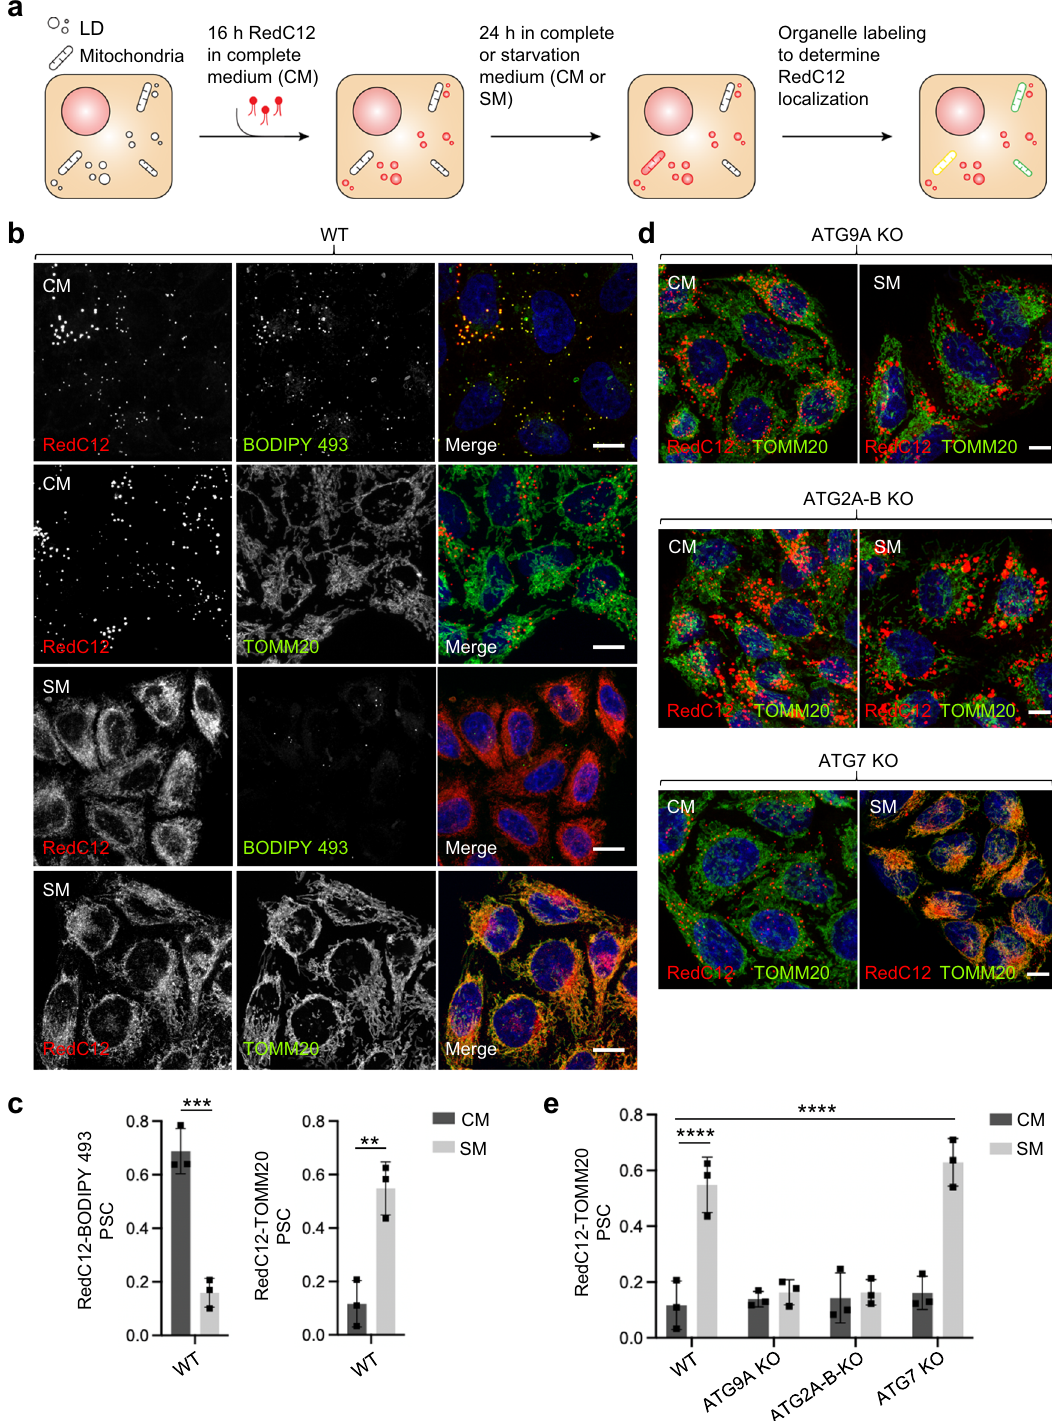
clockwise (Fig. 6a, right-most column) or 90 o counter-clockwise (Supplementary Fig. 6a). This quanti fi cation yielded a PSC of approximately 0.2 for ATG9A vs. GFP-ATG2A and approxi- mately – 0.1 for both rotation controls (Fig. 6b and Supplementary Fig. 6b). Similar results were obtained for the co-localization of endogenous ATG9A with LDs labeled with BODIPY 493 (Fig. 6c,d, Supplementary Figs. 5e and 6c, d). Further immuno fl uorescence microscopy analyses showed that endogenous ATG9A and mitochondria labeled with